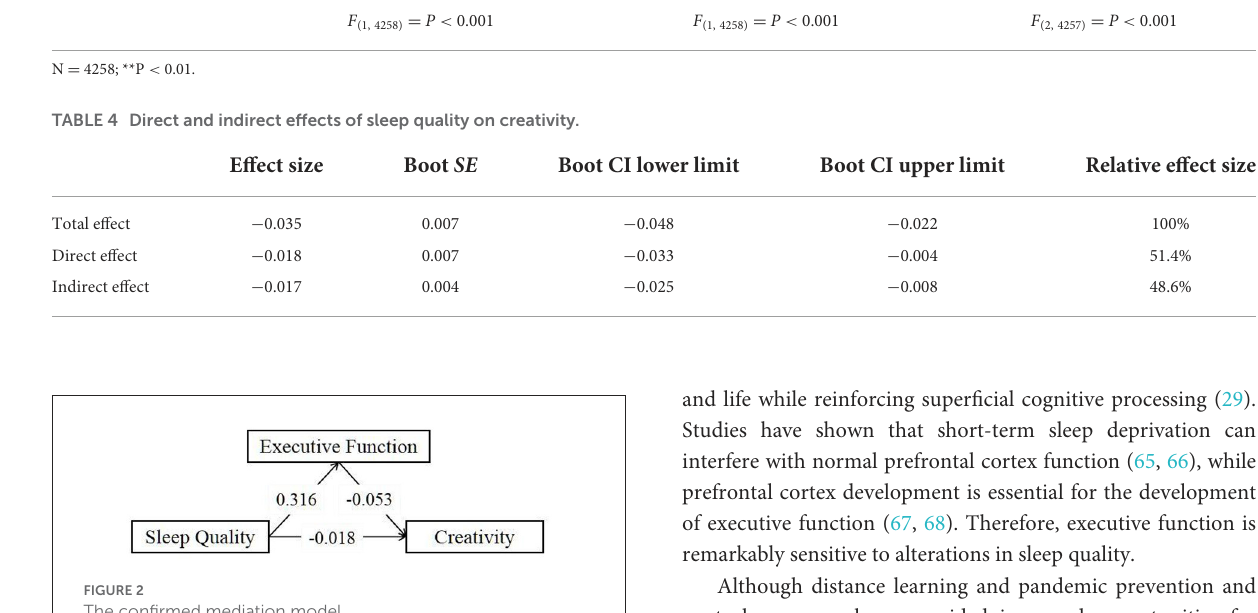
FIGURE2 The confirmed mediation